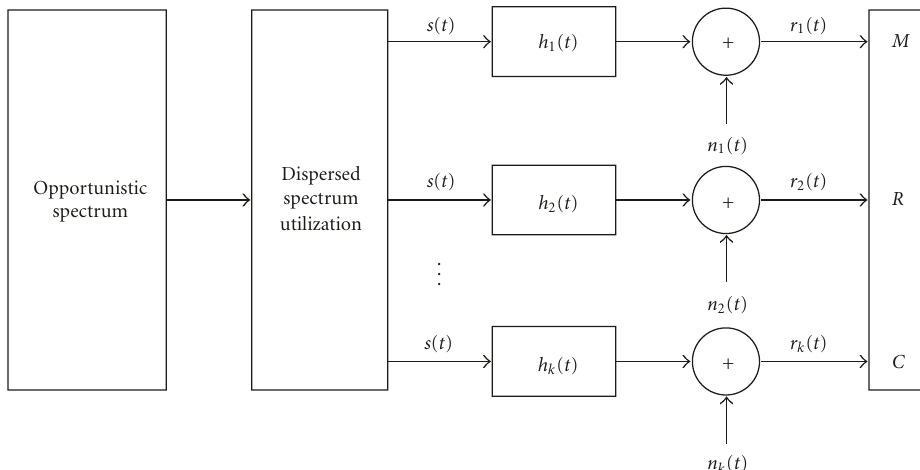
Figure 2: Baseband system model for dispersed spectrum cognitive radio